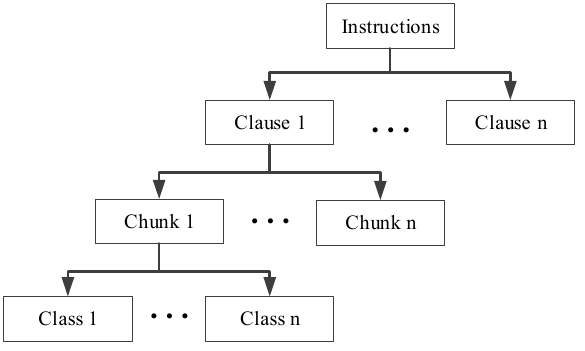
Figure 5. Diagram of structure of instructions.